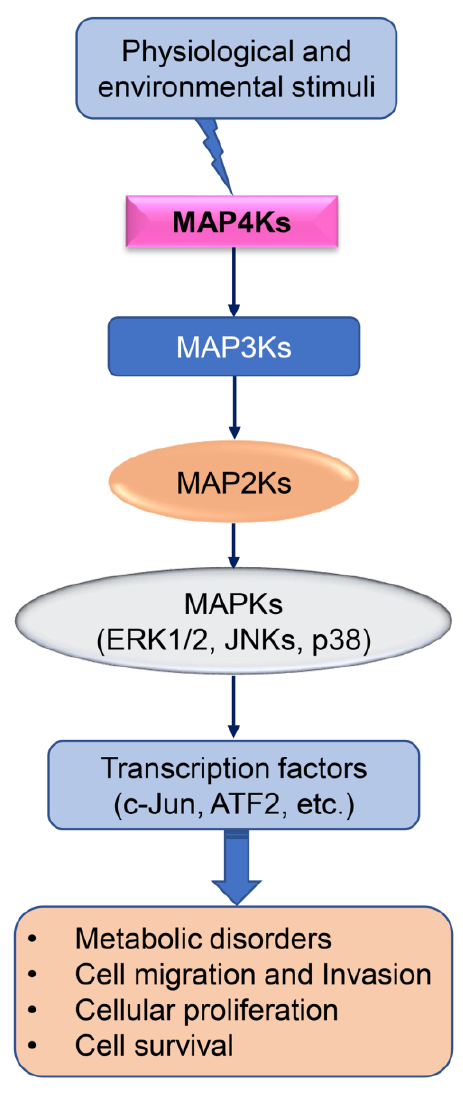
Figure 1. Schematic diagram of MAPK signaling. Physiological and environmental stimuli induce downstream effectors, leading to cellular responses.